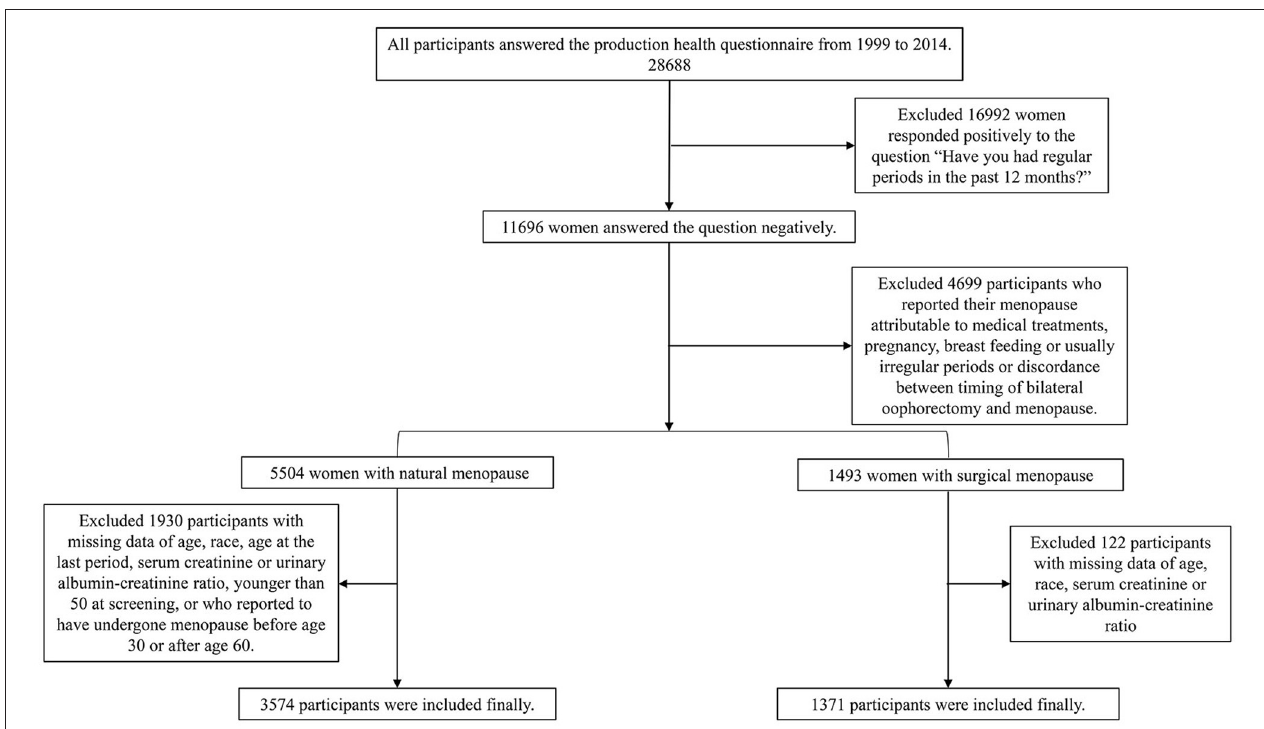
FIGURE 1 | The flowchart of participants’ section